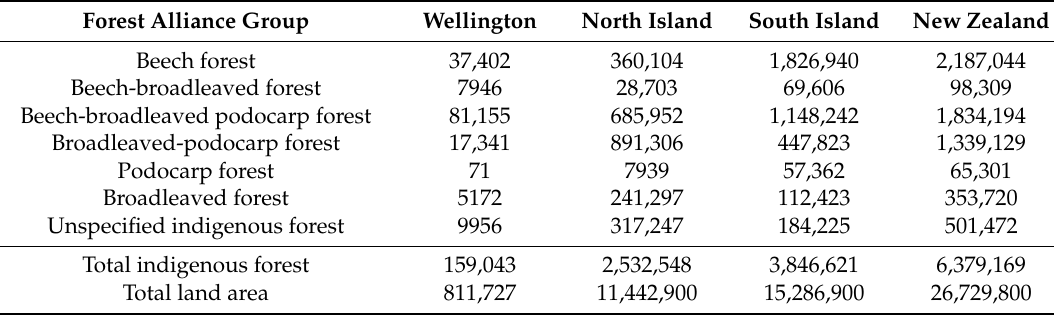
Table 2. Areas in hectares of forest alliance groups in the Wellington Region, North Island, South Island and New